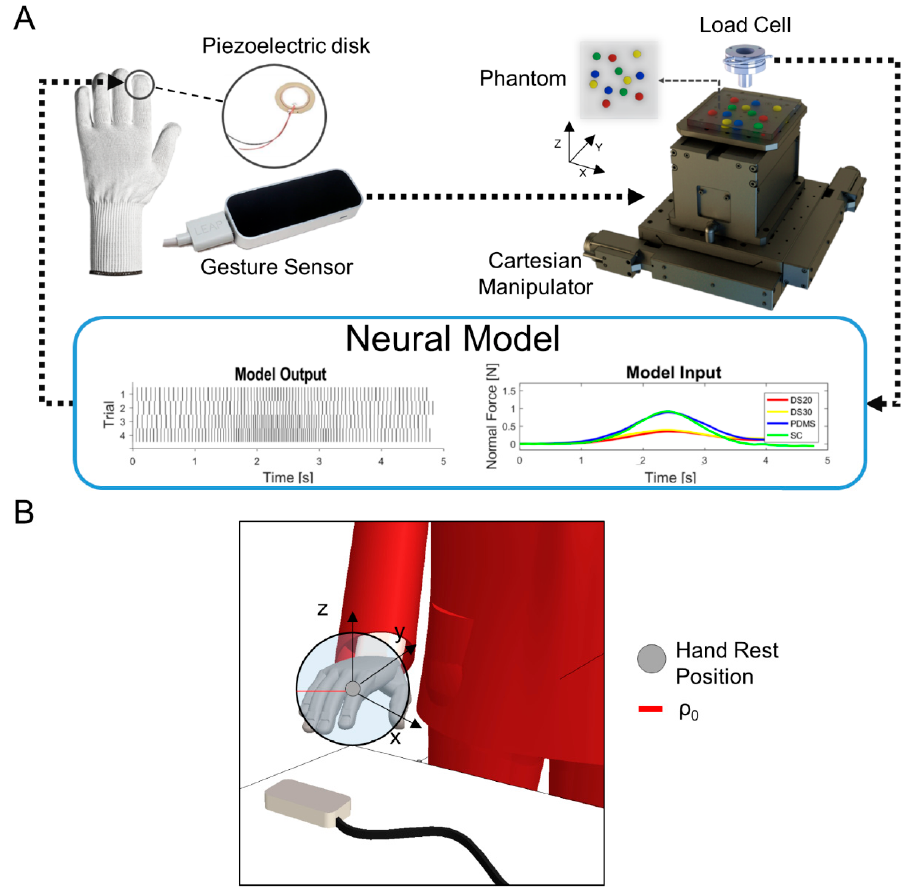
Figure 1. Experimental apparatus. ( A ) Left: the haptic sub-system comprising a textile glove with a detail of the encapsulated piezoelectric disk for index fingertip vibro-tactile stimulation and optical sensor for hand gesture tracking; right: tactile sub-system comprising a 3-axis cartesian manipulator with load cell and the indenter, and a detail on the silicon phantom displaying nodules placement.